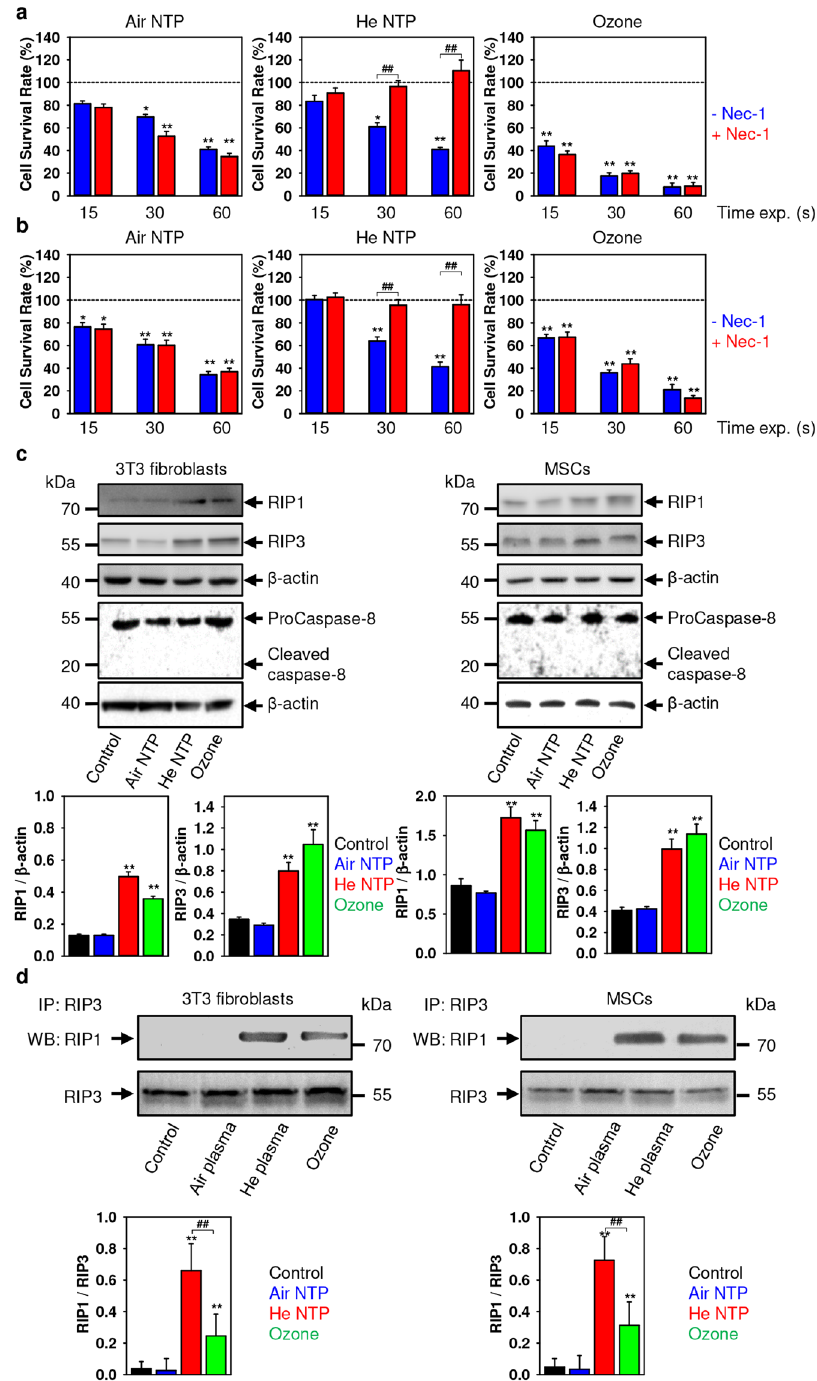
Figure 4. Necrostatin-1 (Nec-1, a potent and selective inhibitor of necroptosis) antagonizes the He NTP- induced cytotoxicity. Cell viability as detected by the WST-1 assay of ( a ) 3T3 fibroblasts and ( b ) MSCs treated with air, helium NTPs or ozone for indicated time periods with supplementation of 10 µ M Nec-1, measured 24 h after exposure. Readings were done in quadruplicates. The data present the mean values of four independent experiments. Data are expressed as means ± SEM (n = 4), * P < 0.05 ** P < 0.01. ( c ) He NTP and ozone treatment induces RIP1 and RIP3 upregulation (full blots of RIP1 and RIP3 are presented in Fig. S5 in Supporting Information) without concomitant activation of caspase-8. 3T3 fibroblasts and MSCs were treated with air, helium NTPs or ozone for 30 s. Cells were analyzed by Western immunoblotting 4 h after treatment. Actin – control of equal protein loading. The graphs show densitometric quantification of RIP1 and RIP3 Western immunoblots, * P < 0.05 ** P < 0.01, mean ± SEM, n = 3. Representative blots out of three independent experiments are shown. ( d ) RIP3 complexes isolated by immunoprecipitation from either 3T3 fibroblasts or MSCs treated with air, He NTPs and ozone for 30 s. The graph shows densitometric quantification of the respective immunoblots, * P < 0.05 ** P < 0.01, mean ± SEM, n = 3. Representative blots out of three independent experiments are